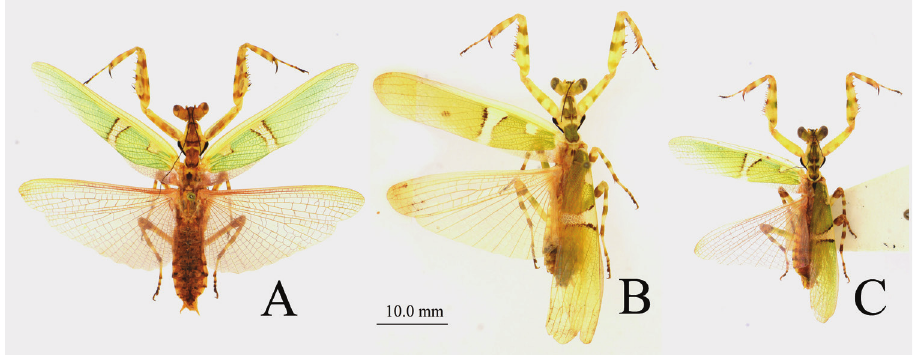
Figure 2. Male Theopropus spp. body in dorsal view A T. sinecus sinecus from Guangxi B T. xishiae sp. nov. paratype C T. sp. from